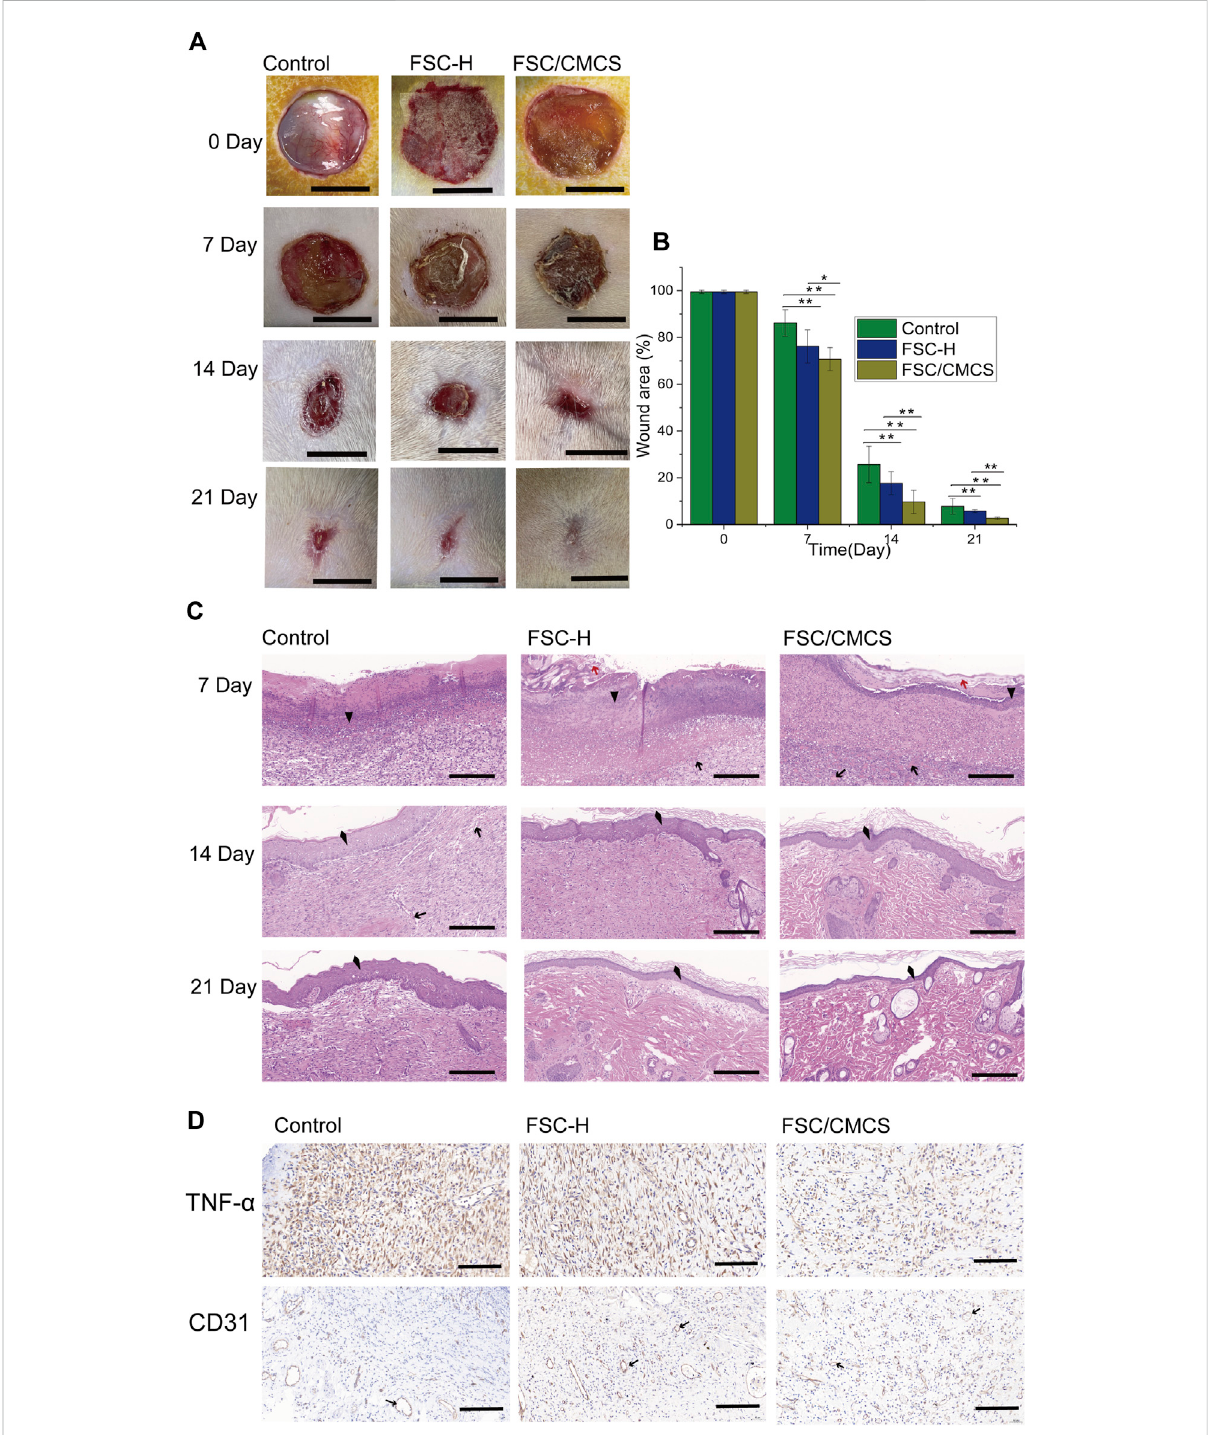
FIGURE 7 Digital images of macroscopic wound conditions and histological images. (A) Digital photographs of wounds taken on days 7, 14, and 21. (B) Percentages of wound size compared to the initial sizes. (C) H&E staining of sections of wounds treated with different materials on different days, respectively. (D) Immunostaining of TNF- α and CD31 in granulation tissues after 7 days. In immunohistochemistry, the nucleus is blue and the positive expression is brownish yellow. Arrows, red arrows, triangles, and quads represent new blood vessels, silk fi ber, in fl ammatory cells, and new epithelium, respectively. Scale bars in (A) are 1 cm, and in (C) and (D) are 100 μ m, vs. the control group, ( n = 3, * p < 0.05, ** p <